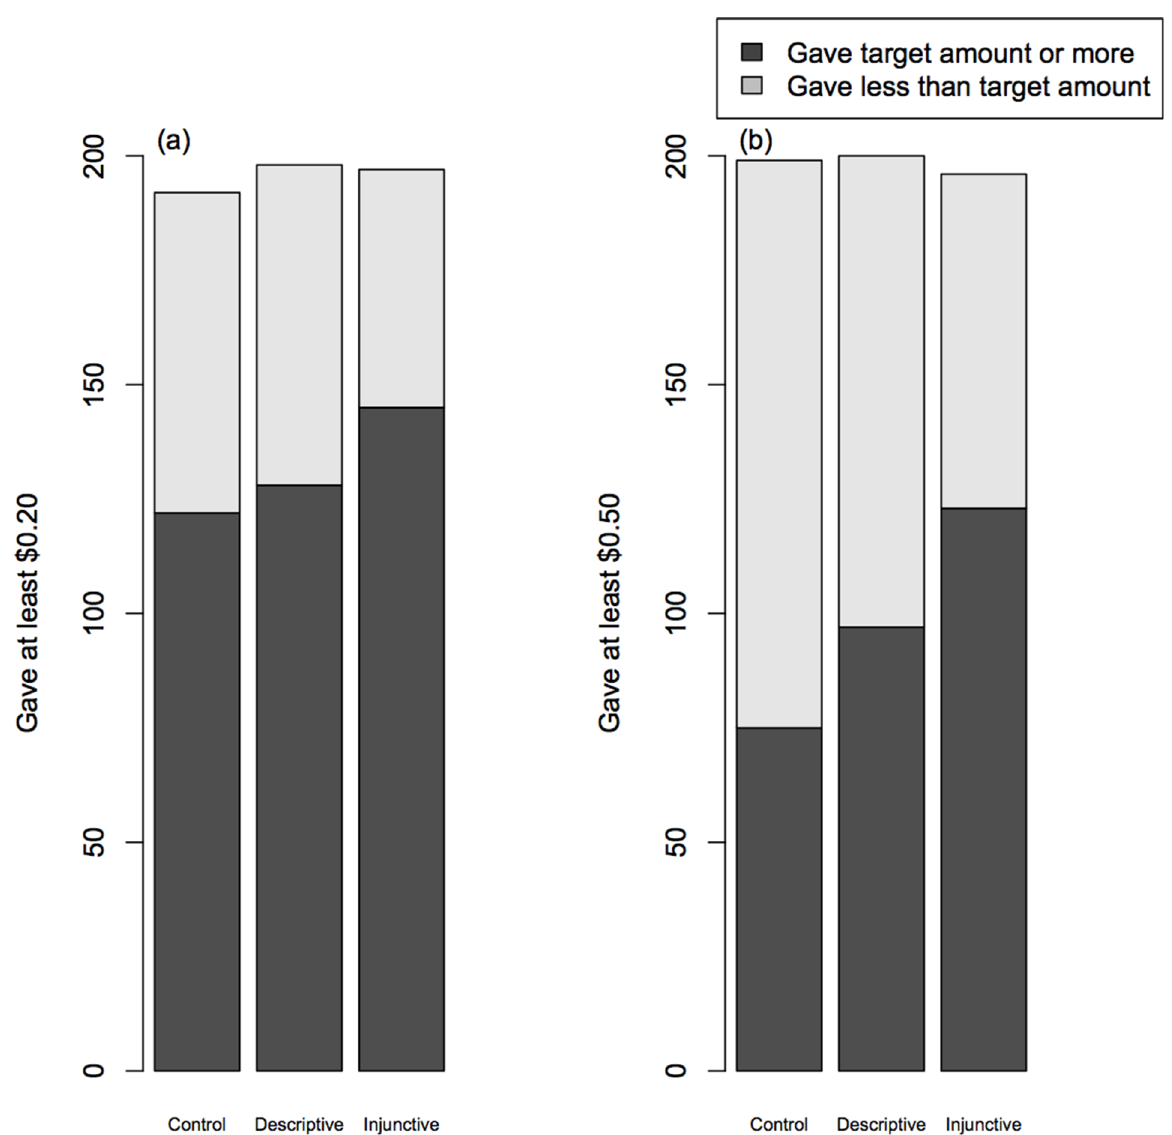
Fig. 2. Numbers of Player 1 who complied with the norm to give (a) at least $0.20 or (b) at least $0.50 to Player 2 according to the type of norm information that was used in the instructions. Control data are those where no norm information was